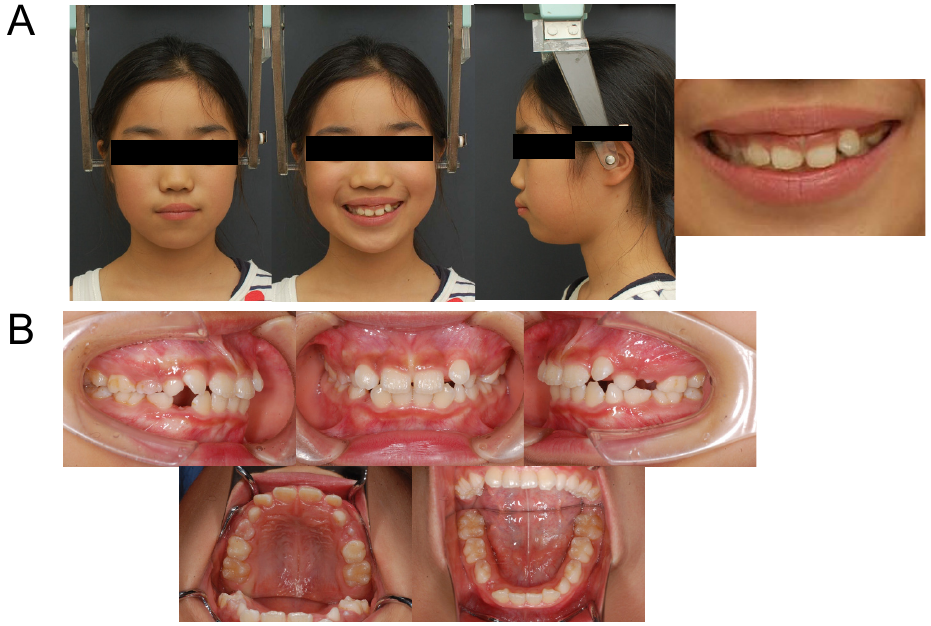
Figure 12. Facial photographs and intra-oral photographs at initial examination for Case 3; facial photograph and enlarged photograph of the mouth at initial examination ( A ); intra-oral photograph at initial examination ( B ).